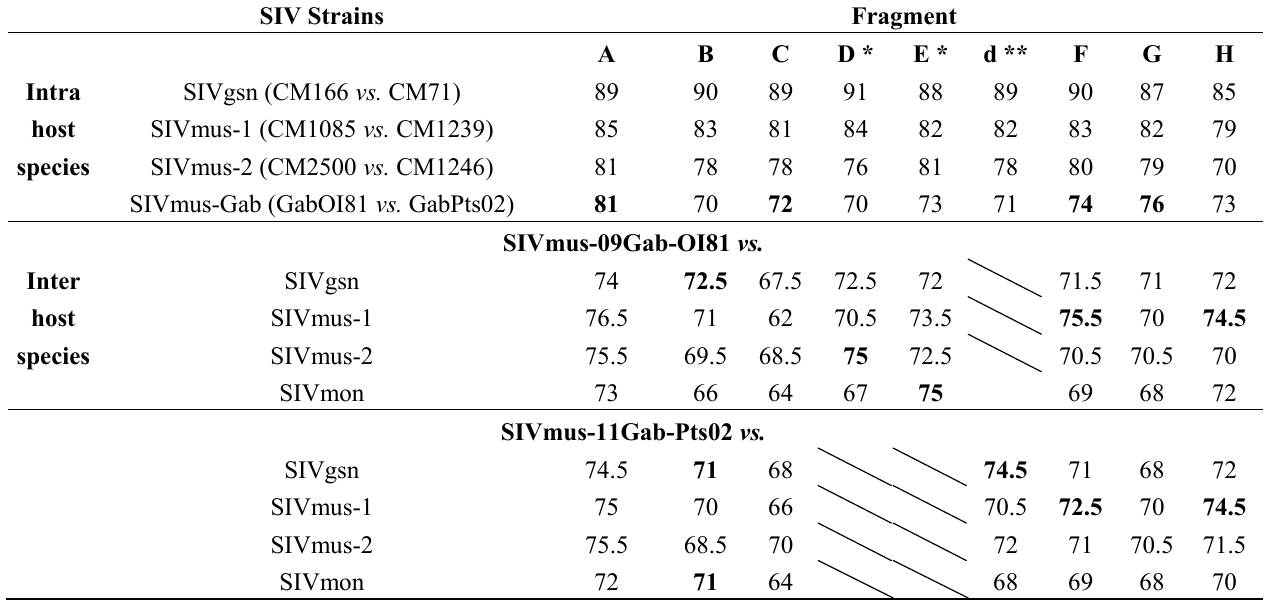
*: Specific fragments used for SIVmus-09Gab-OI81 phylogenetic analyses according to Figure 6; **: Specific fragments used for SIVmus-11Gab-Pts02 phylogenetic analyses according to Figure